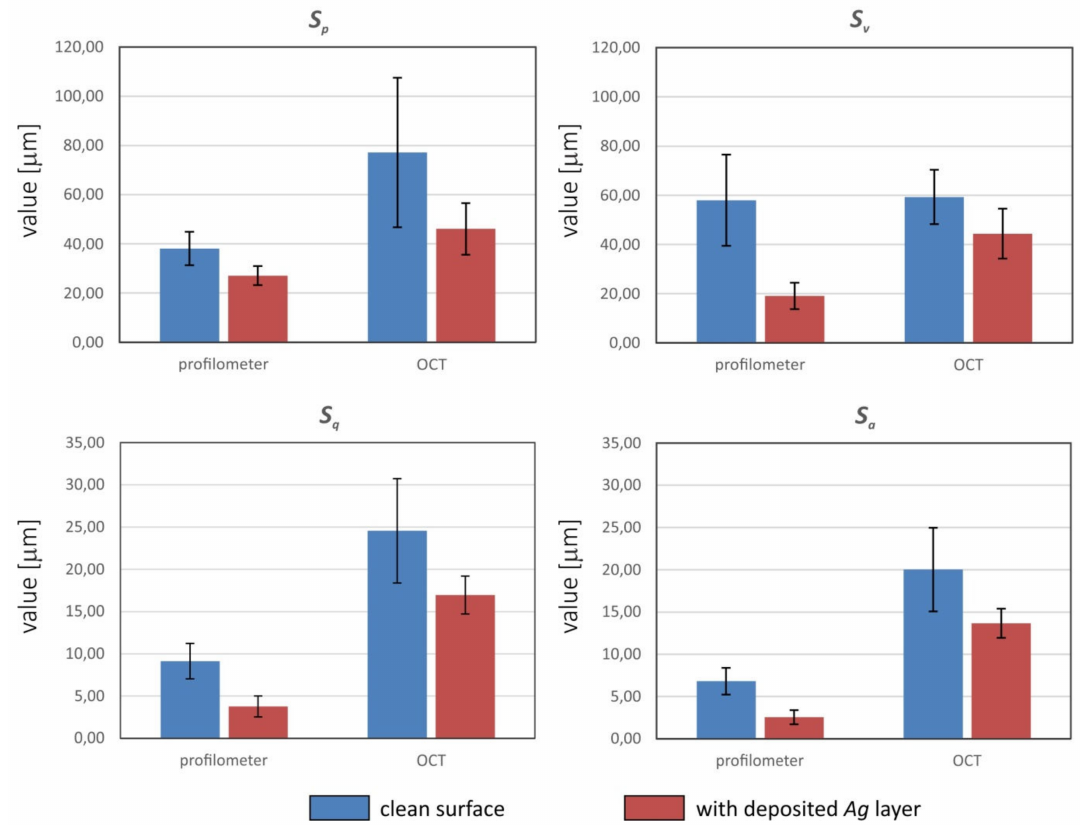
Figure14. Comparisonoftheroughnessparametervaluesobtainedwithtwomethods: usingaprofilometer and OCT analysis.